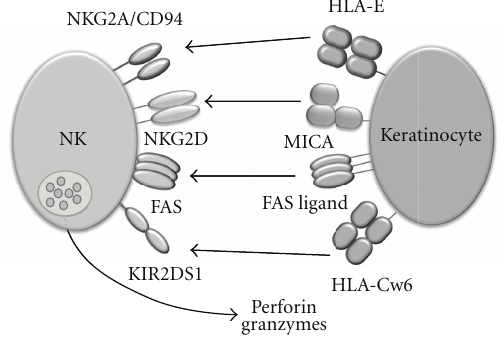
Figure 1: NK cells can interact with keratinocytes through a range of cell surface receptors. NK cells express cell surface receptors that regulate their interactions with other cell types including ker- atinocytes. Among these receptors is the NKG2A/CD94 inhibitory receptor that recognises and binds to HLA-E on target cells. NK cells alsoexpress a number of activating receptors including NKG2D which recognises MICA/B stress antigen and the Fas receptor which can activate cytokine secretion by NK cells. The activating KIR receptor 2DS1 (and its inhibitory counterpart, 2DL1) binds the HLA-Cw6 molecule and HLA-Cw6 is the strongest genetic association known in psoriasis. There is evidence in the literature to suggest that these receptors play a role in psoriasis. Activated NK cells are triggered to release their cytotoxic granule contents which contain perforin and